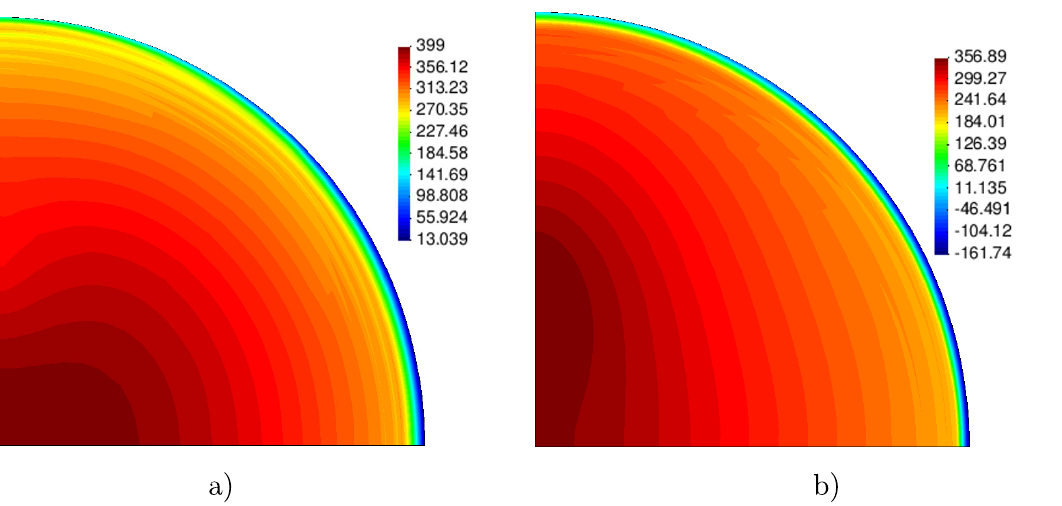
Figure 13. Computed in-plane ( a ) maximum and ( b ) minimum principal stress contours (in MPa) at the outer surface of the bulge sample for the maximum dome height (RD is the horizontal